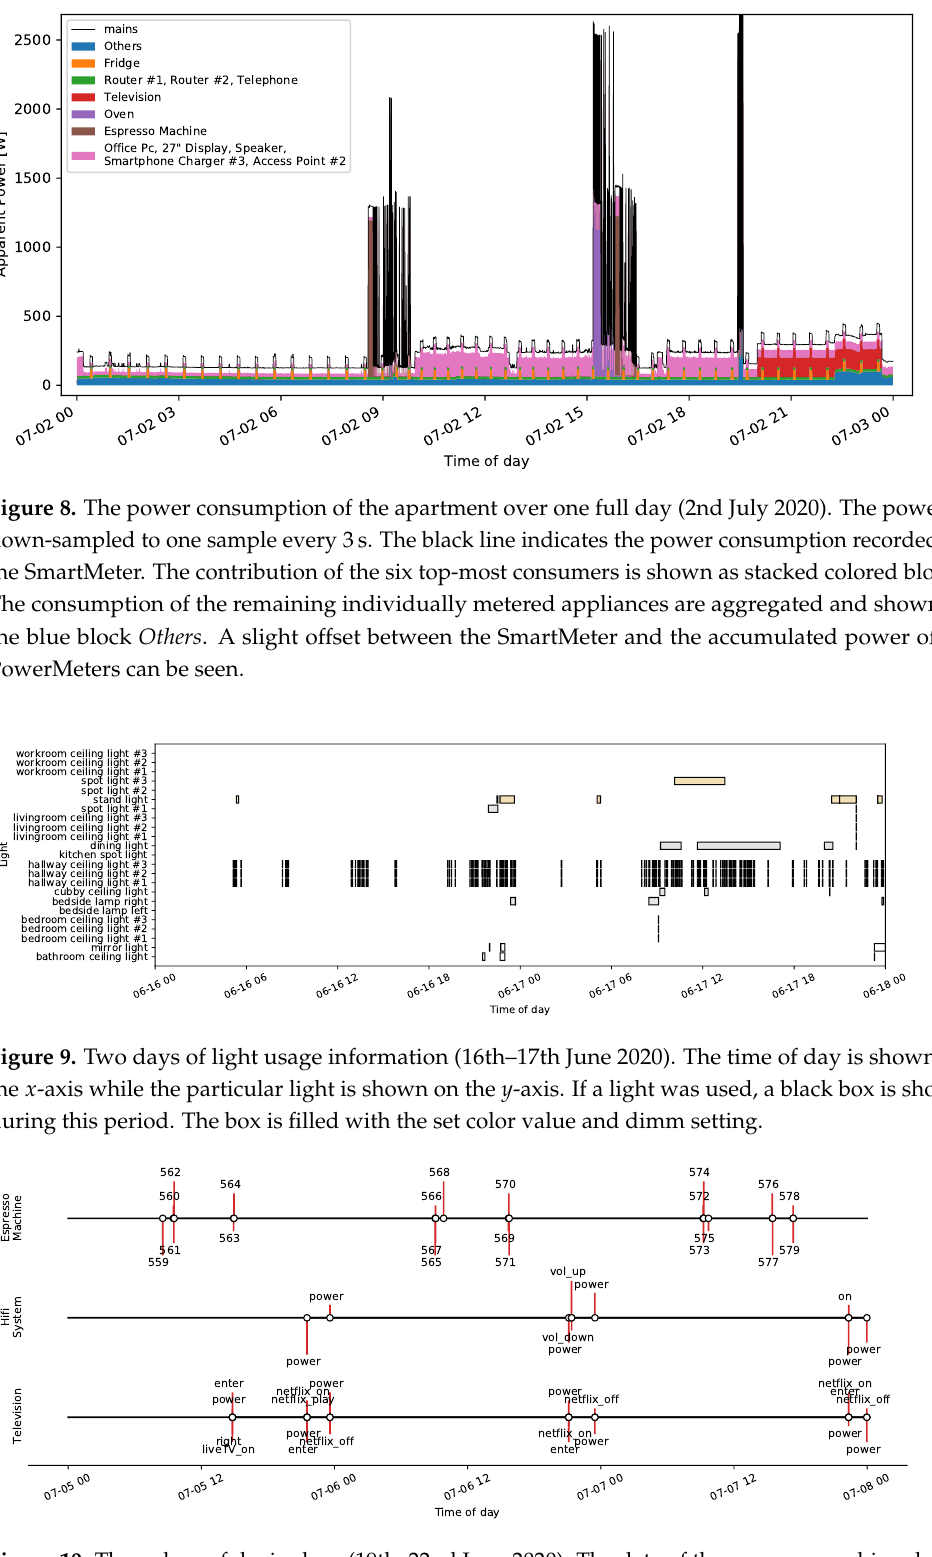
Figure 10. Three days of device logs (19th–22nd June 2020). The data of the espresso machine shows the numbers of espressos made, while the data of the HiFi system and television show key-presses on the remote. The television content is provided by a connected media